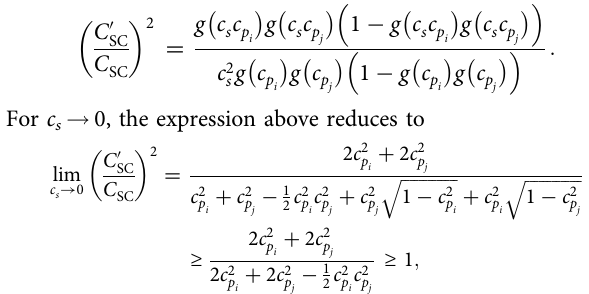
ffiffiffiffiffiffiffiffiffiffiffiffiffiffiffiffiffi q 1 (cid:2) c 2 s c 2 p